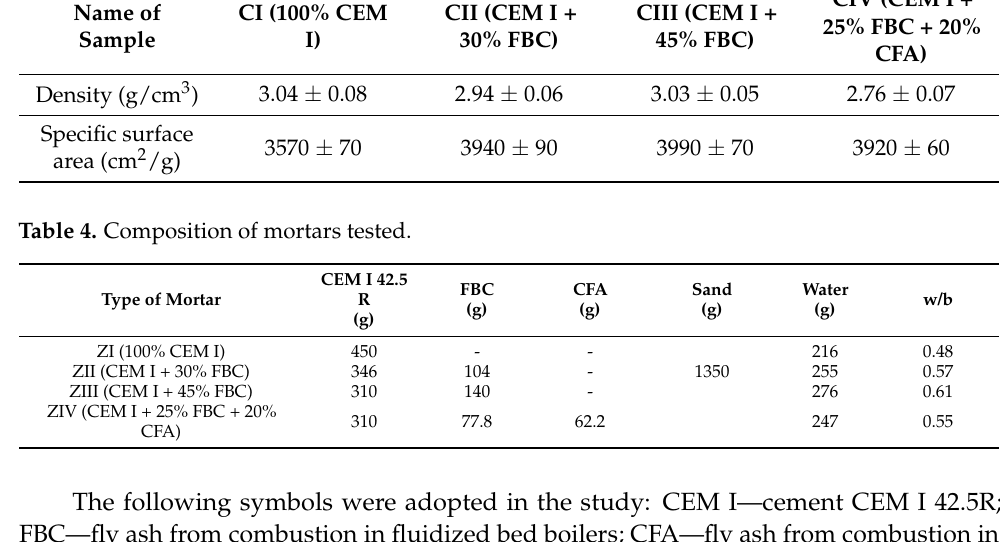
Table 3. Density and surface area of cementitious-fly-ash binders. Table 4. Composition of mortars tested.